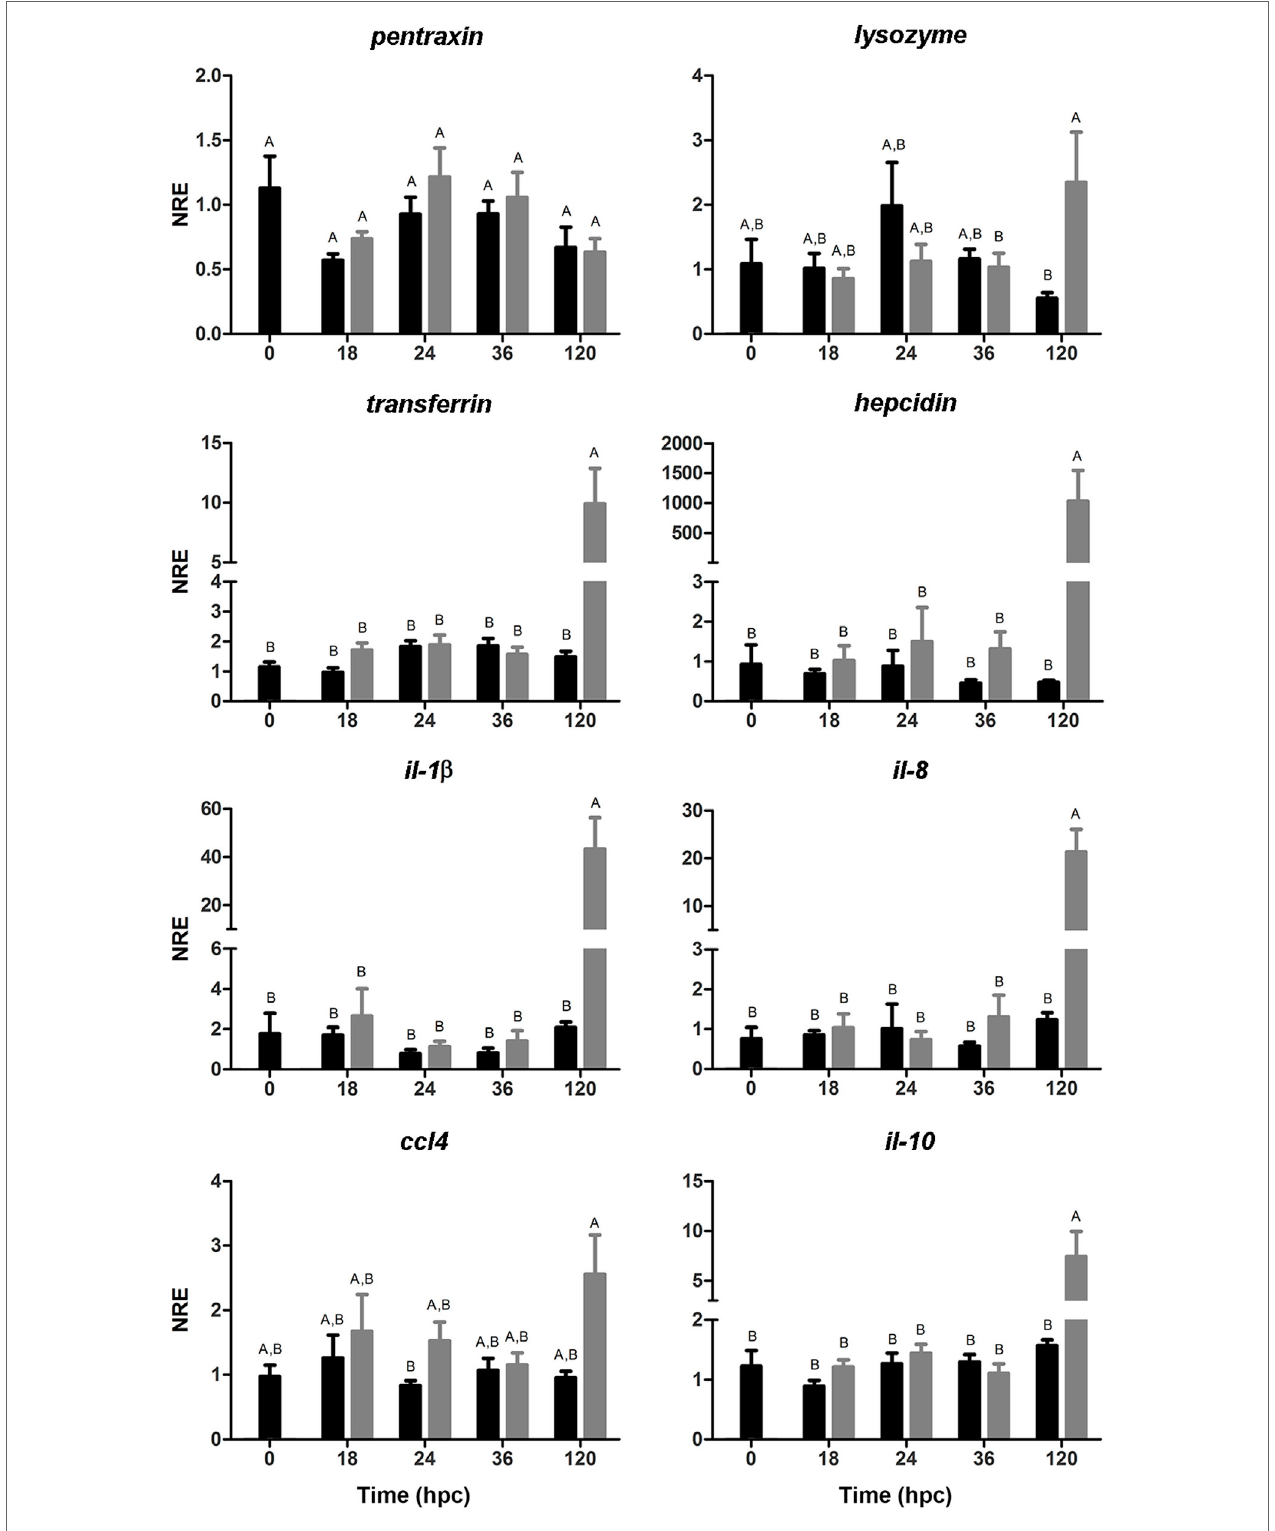
FigUre 5 | Normalized relative expression (NRE) analysis (mean ± SE) of immune-related genes in full-sibling sea bass larvae challenged with Vibrio anguillarum . The expression of pentraxin , lysozyme, transferrin , hepcidin , Il-1 β , il -8 , il-10 , and ccl4 was evaluated from whole-single larva ( n = 10 per time point) in each time [hours post-challenge (hpc)] for non-challenged (black bar) and challenged group (gray bar). Significant differences (linear regression model with Tukey correction posttest) are shown by different capital letters (A, B; p <